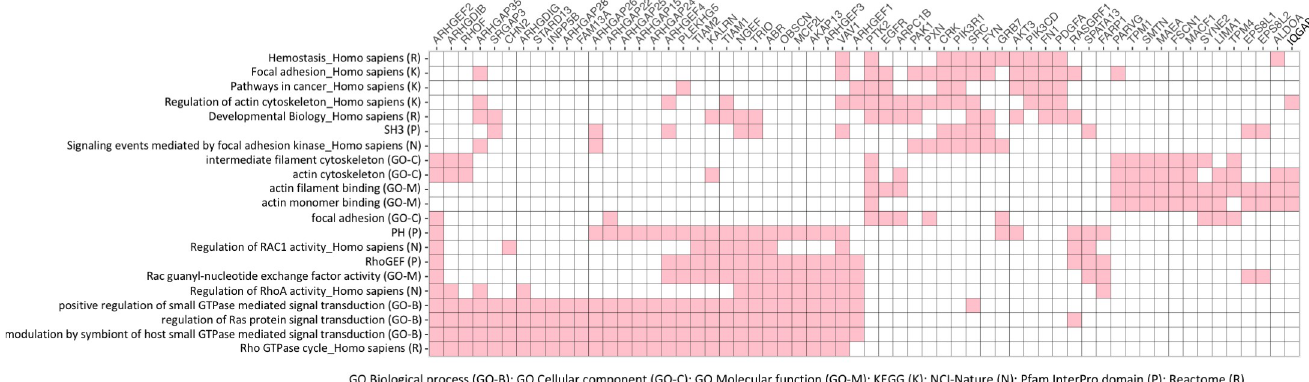
Fig 6. Genes exhibiting DNAm-correlated isoform usage in multiple cancer types show pathway and functional relationships. Red squares indicate involvement in 21 pathways/gene sets ( rows ) for 60 genes with DNAm-correlated isoform usage ( columns ). The 21 pathways/gene sets are the most frequently enriched from assessments of seven pathway/gene set databases ( listed on bottom left ). The genes were part of a larger set of 1,222 genes whose DNAm and isoform usage were correlated in at least 6 (out of 11) cancer types.